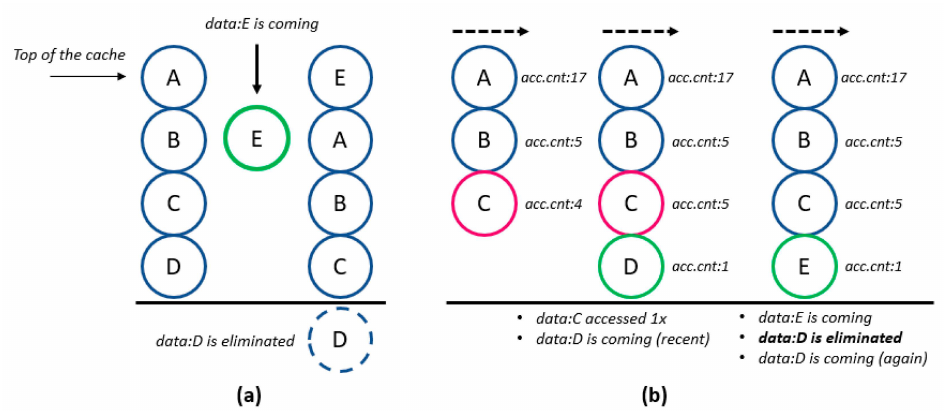
Figure 1. ( a ) LRU algorithm concept; and ( b ) how the LFU